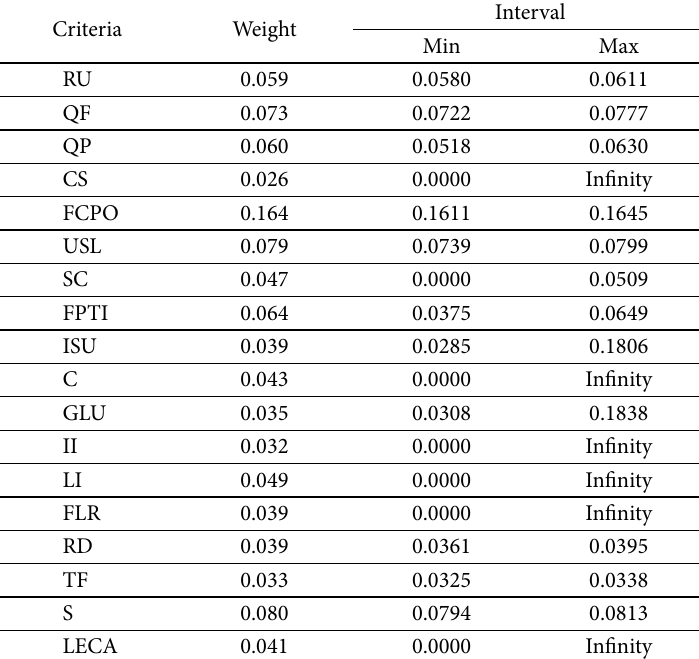
Table 14. Stability